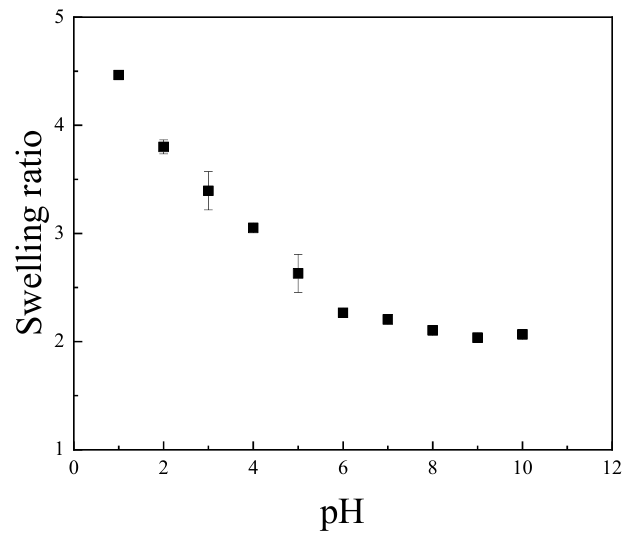
Figure 3. pH responsiveness of PCB/PSB IPN hydrogel at 25 °C in distilled water.